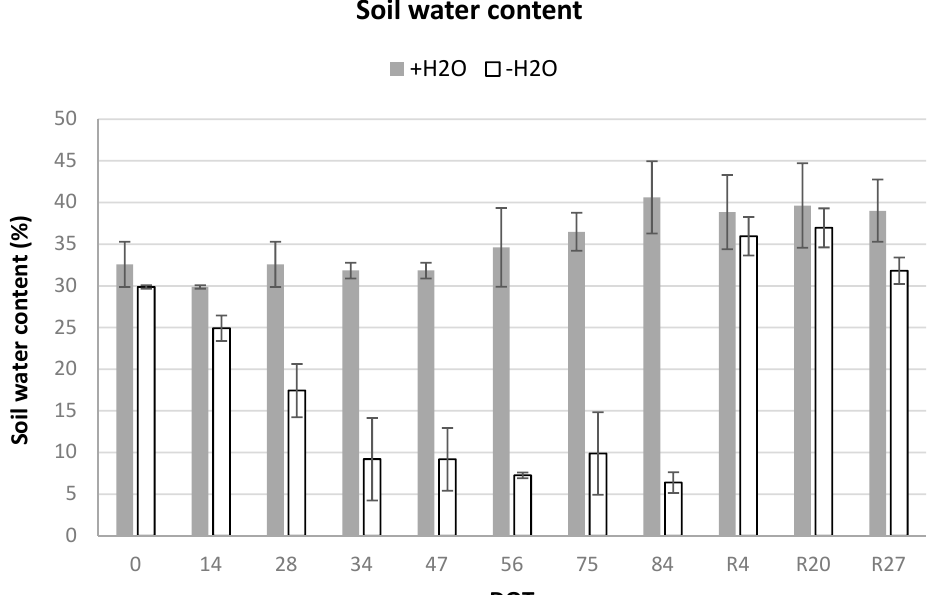
Figure 2. Soil water content (SWC, %), measured in the first 10 cm during the experimental period, in the irrigated (+H 2 O) and water-stressed ( − H 2 O) mesocosms of Fraxinus ornus . On the horizontal axis, the Day of Treatment (DOT) is reported (0–84 = days from the last irrigation and R4, R20, R27, days from re-watering of the water-stressed mesocosms). Data are means ± S.D., N = 6.